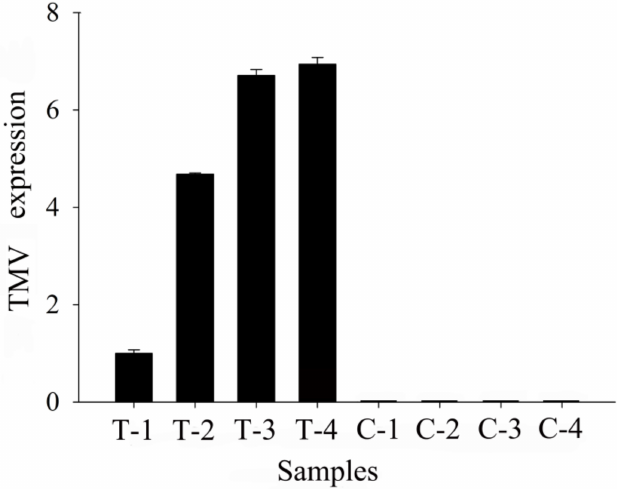
Figure 1. Tobacco mosaic virus (TMV) expression determined by qRT-PCR after 48 h of TMV